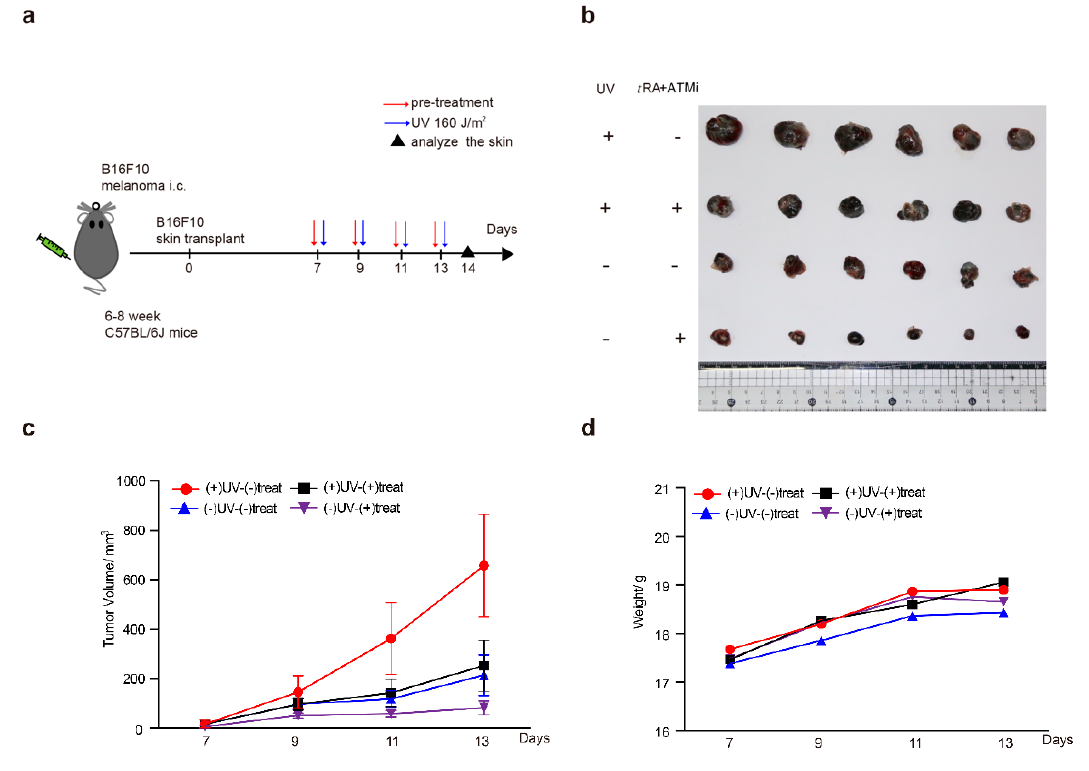
Figure 6. t RA and ATMi inhibited UV-induced VEGFA expression in melanoma cells. ( a )